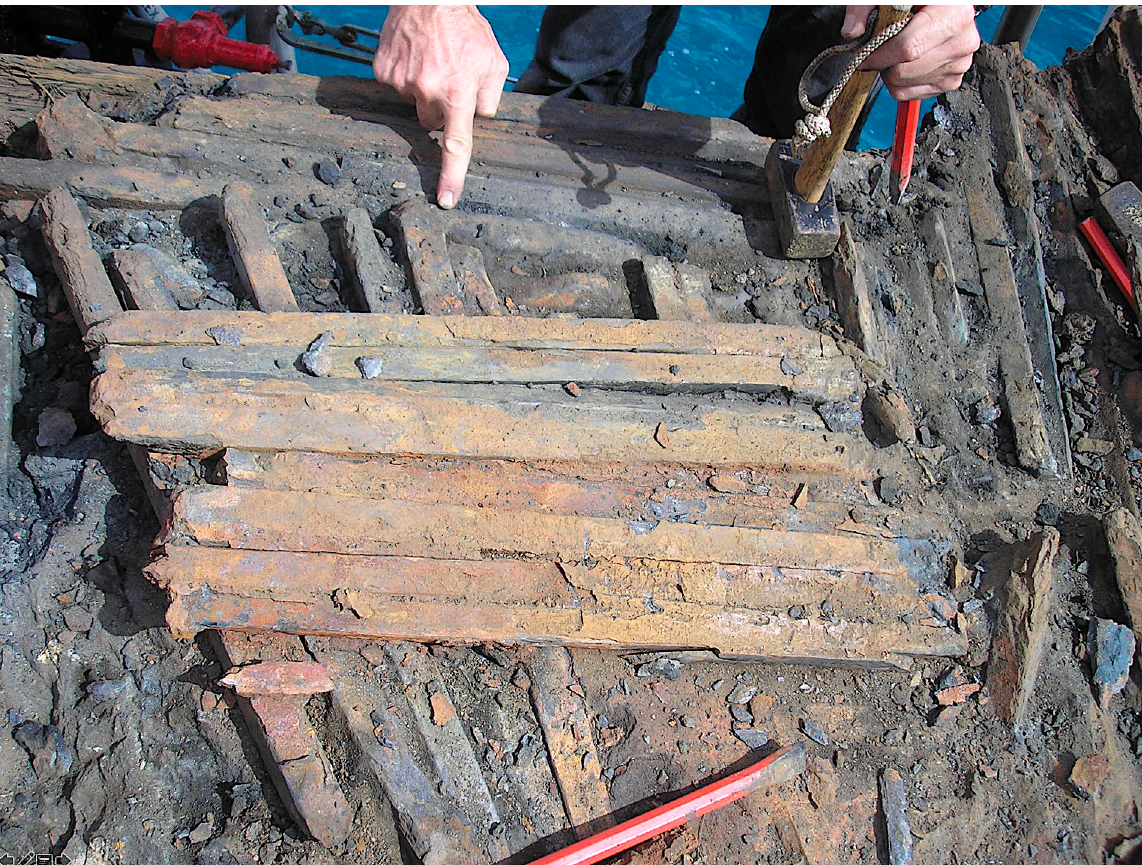
Fig 2. Small portion of a cargo of iron bars carried on the Saintes-Maries-de-la-Mer wrecks (pictured here, type-2M bars from the SM25 wreck).